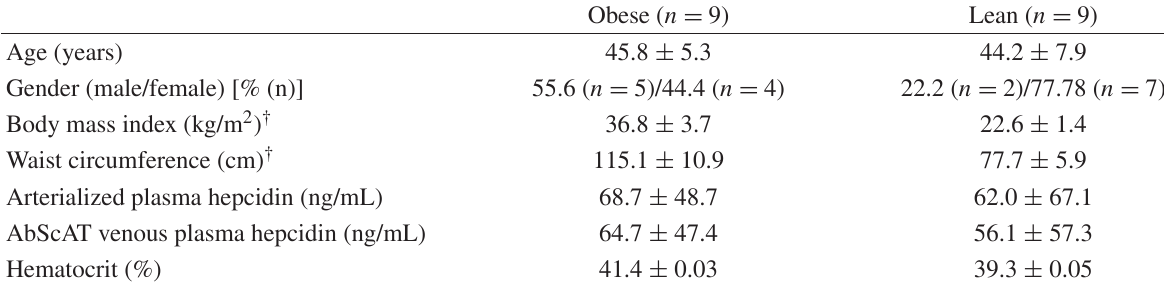
TABLE 1: Demographic and clinical characteristics of Caucasian obese and lean adults ( n = 18